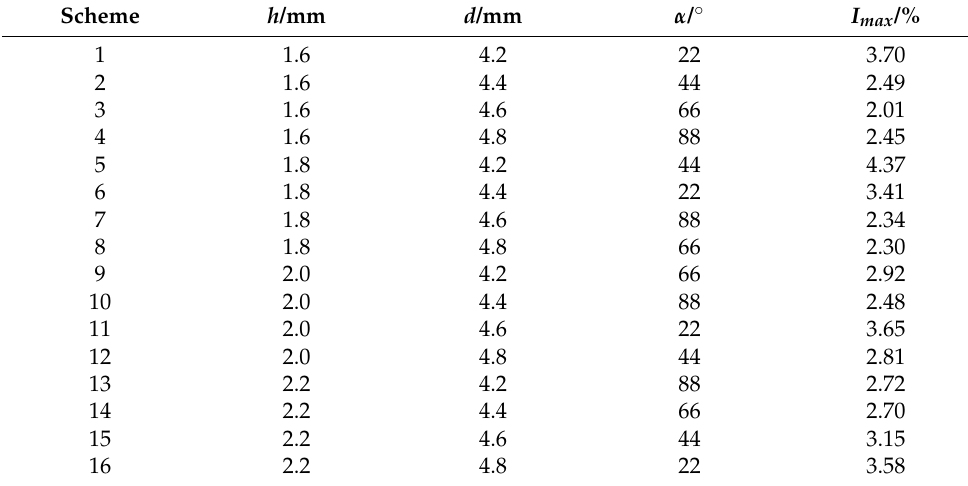
Table 3. The schemes and results of the research design.